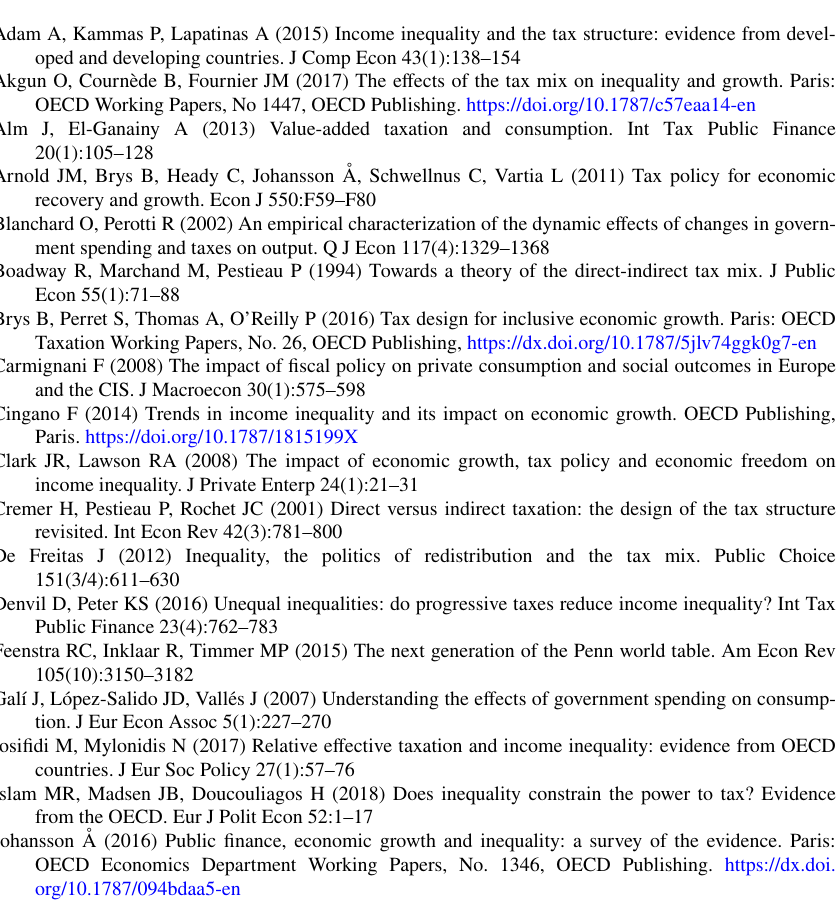
The non-bold and bold values presented in the short-run and long-run columns express, respectively, the maximum and minimum threshold tax items levels. The values expressed in italics represent average